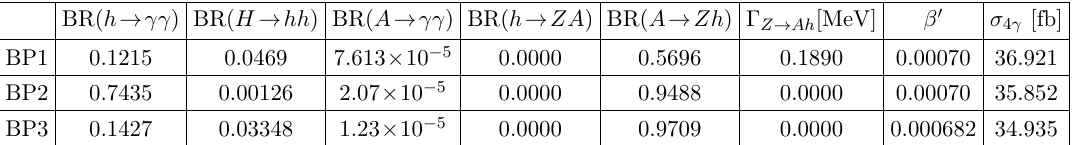
Table 3. Input parameters, BRs of CP-even and CP-odd Higgs bosons, Z boson width and four photon cross section corresponding to the selected BPs. All widths are in MeV and for all points m H = 125 GeV.